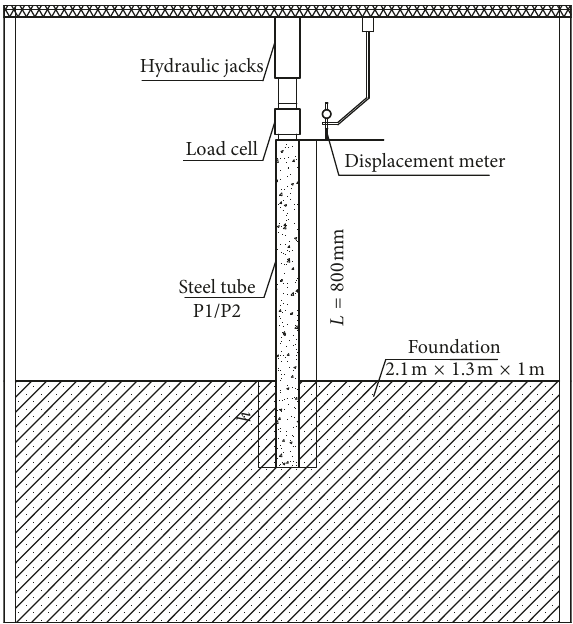
Figure 4: Test setup ( h means rock-socketed depth; P1: steel tube is 1 mm; P2: steel tube is 0mm).